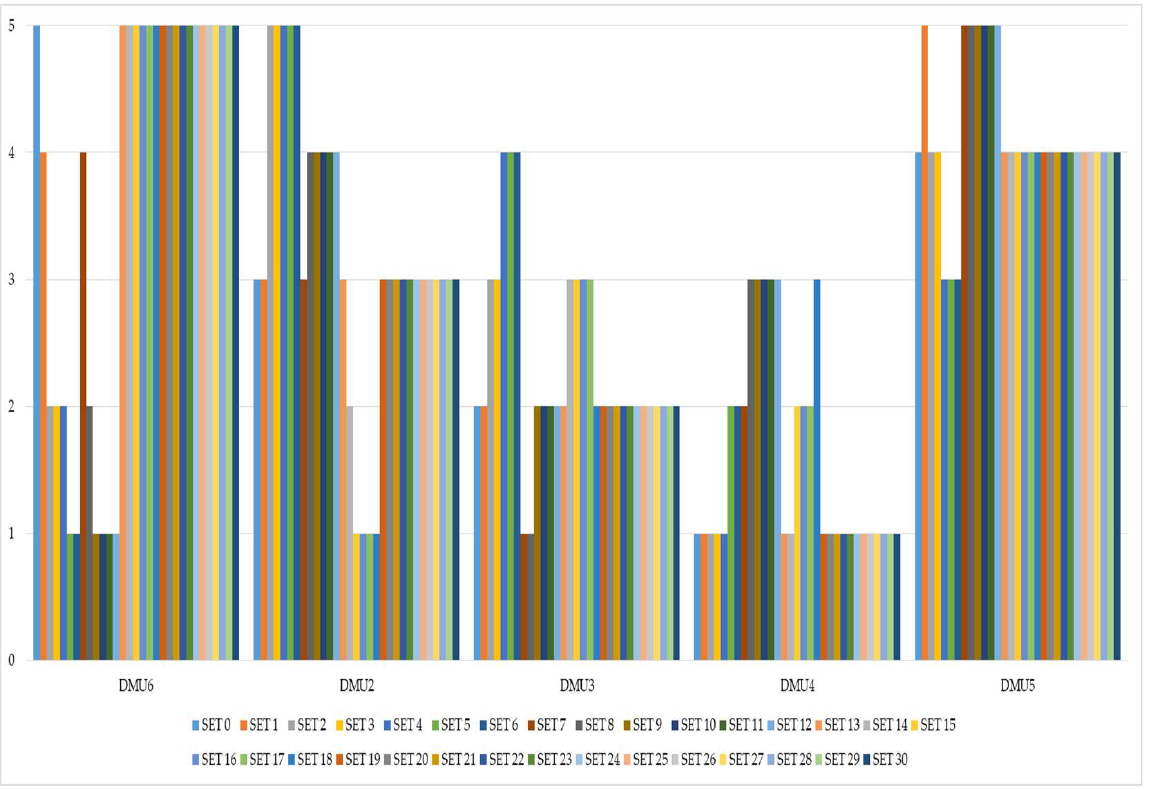
Figure 10. Results of sensitivity analysis for 30 newly formed scenarios for both companies.